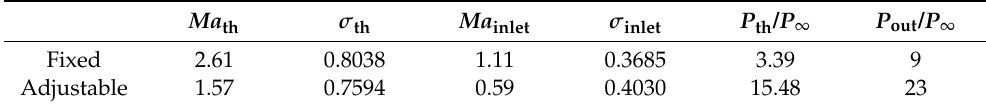
Table 4. Comparison of the parameters ( Ma ∞ = 3.5).